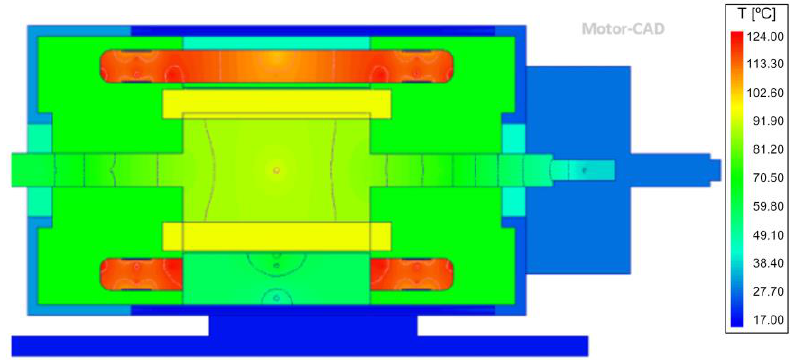
Figure 13. Axial view of water-cooled motor (aluminum casing) after the FEM analysis.